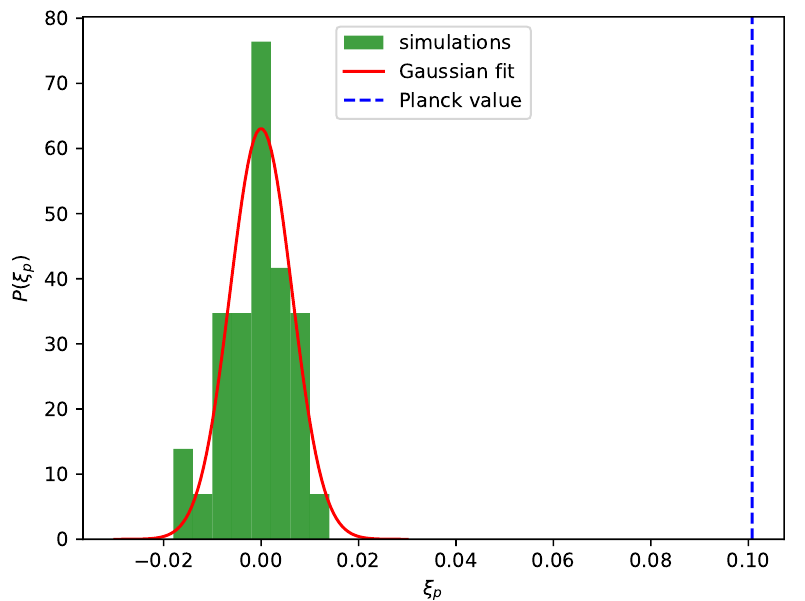
Figure 2. Gaussian fit to the histogram of LR63 masked ξ p from 36 DUSTFILAMENTS simulations. The measured Planck ξ p is in 15.9 σ tension with the Gaussian